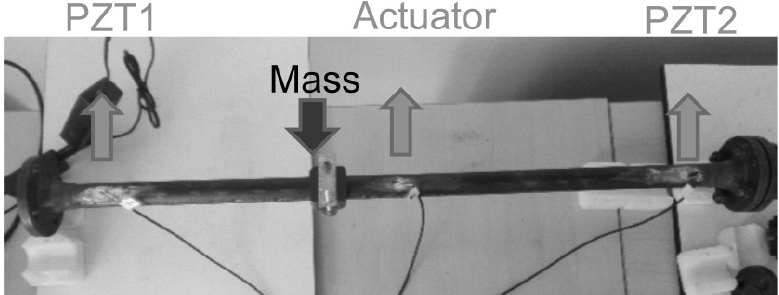
Figure 10. Pipe Section experiment